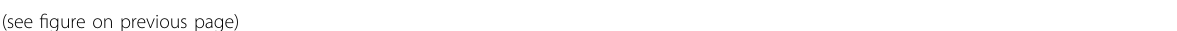
Fig. 6 Treatment of CXCR2 antagonist suppresses low SLC7A2-mediated HCC metastasis. A , B Conditioned media (CM) from Hepa1-6 clones was placed in the lower chambers with different concentration of SB265610 (0, 100,1000ng/mL, 24 h). Freshly Myeloid MDSCs were put in the upper chambers and invasion for 24 h. Total numbers were counted. The scale bars represent 100 μ m. The data are shown as the mean ± SD from the at least three independent experiments; * P < 0.05, ** P < 0.01. C Pre-treated with mCXCL1 (10 ng/mL, 24 h) and SB265610 (100 ng/mL, 24 h), the chemotaxis index of mouse MDSCs is shown. The data are shown as the mean ± SD from the at least three independent experiments; * P < 0.05. D Tumor growth in mice subcutaneously injected with Hepa1-6-shcontrol or Hepa1-6-shSLC7A2 cells, treated with CXCR2 antagonist (SB265610: 2 mg/kg body weight) or PBS six times a week from day 1 after tumor inoculation. n = 10. E Flow cytometric images of subcutaneous Hepa1-6- shcontrol or Hepa1-6-shSLC7A2 cells treated with SB265610 or PBS at day 27. CD8 + T cells (upper) and MDSCs (lower). Flow cytometric analyses the ratio of CD8 + T cells and MDSCs between groups at day 27 respectively, n = 10. The data are shown as the mean ± SD from the at least three independent experiments; * P < 0.05, ** P < 0.01, and *** P < 0.001. F Immuno fl uorescent staining of the CD11b, CD8, and granzyme B protein expression patterns in mice tumor cells. G – K In vivo assays shown that the treatment of SB265610 can block knock-down SLC7A2-mediated HCC metastasis. G The representative Bioluminescence images were shown in the different groups, treated with SB265610 or PBS in the C57BL/6 injected with the indicated cells in the liver, n = 10. The Bioluminescence intensity in the tumors at the indicated time point was presented as the total photon fl ux. H Incidence of lung metastasis I the number of metastatic lung nodules in lung in the C57BL/6 mice. n = 10. J Overall survival of the mice in each group. K Representative H&E-stained lung metastatic nodules. The scale bars represent 1 mm (upper panel) and 100 μ m (lower panel). Images shown are representative of at least three independent experiments. * P < 0.05, ** P <